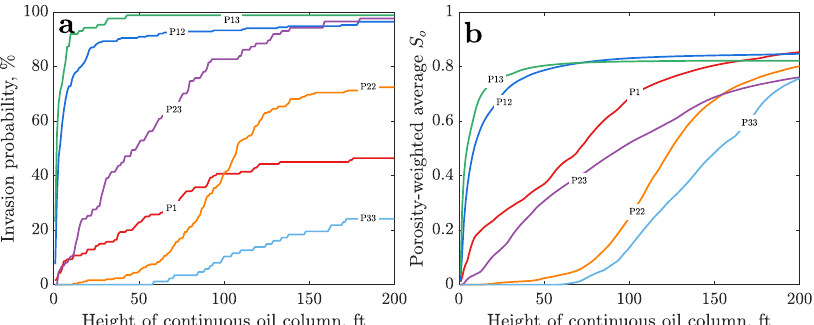
Figure 5. ( a ) The probabilities of invading different nested porositons in the carbonate database from Clerke et al. [24]; ( b ) the corresponding porosity-weighted oil saturations in the nested porositons. P1 denotes primary drainage of cores with only P1inM. P12 is drainage of only porositon 1inM in the cores with two porositons 1 and 2. P22 is drainage of porositon 2 in the cores with 2in1inM. P13 is drainage of porositon 1inM in the cores with three porositons. P23 is drainage of porositon 2in1inM and P33 is drainage of porositon 3in2in1inM in the cores with three